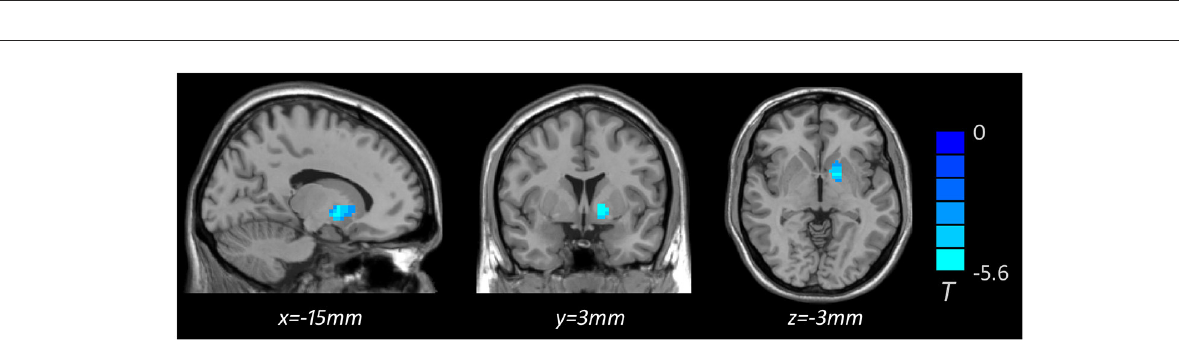
FIGURE3 Brain region showing significant structural difference between MDD with and without anhedonia ( p < 0.05, GRF corrected ). The color scale represents t